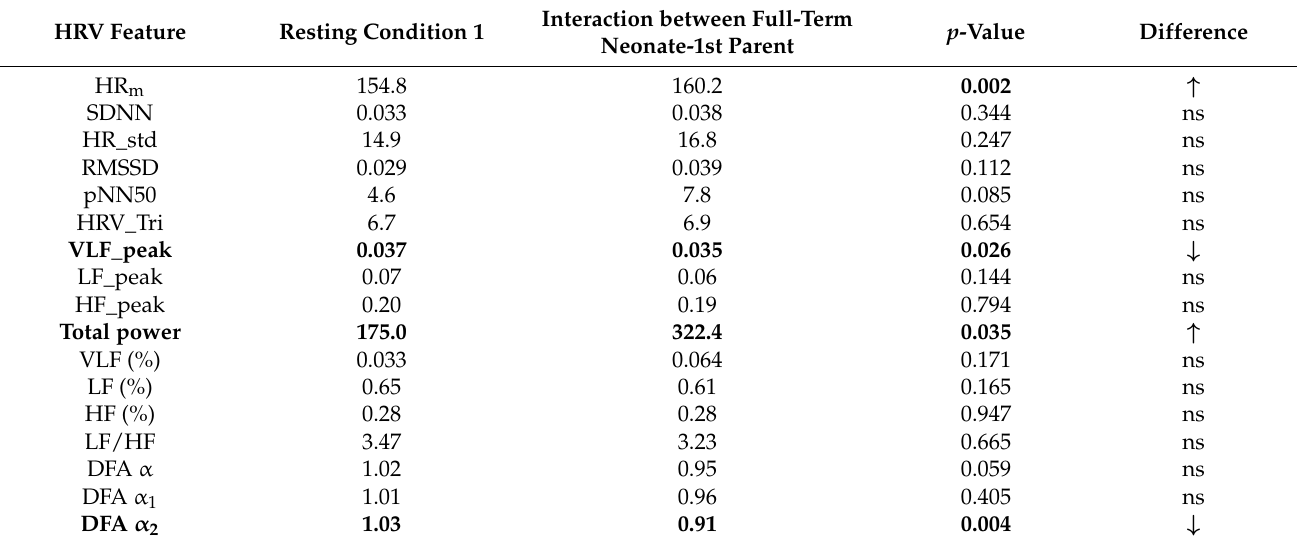
Table 5. Comparison of full-term infants’ HRV parameters between resting condition 1 and interaction with the 1st